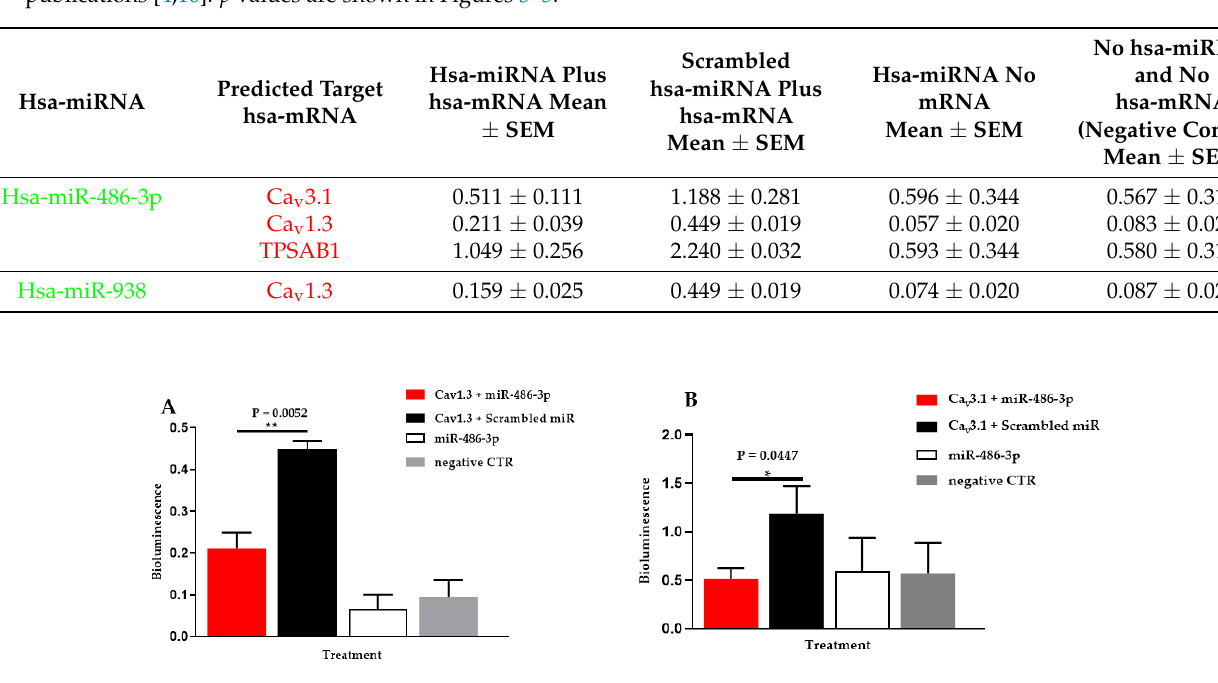
Table 3. Significant downregulation of hsa-mRNAs by hsa-miRNAs in H9C2 cells, observed following luciferase assay experiments. Mean ± SEM values are shown. Red represents significantly more expressed mRNA in the SN vs. right atrium, whereas green represents significantly less expressed miRNA in the SN vs. right atrium, as shown in our previous publications [4,10]. p values are shown in Figures 3–5.